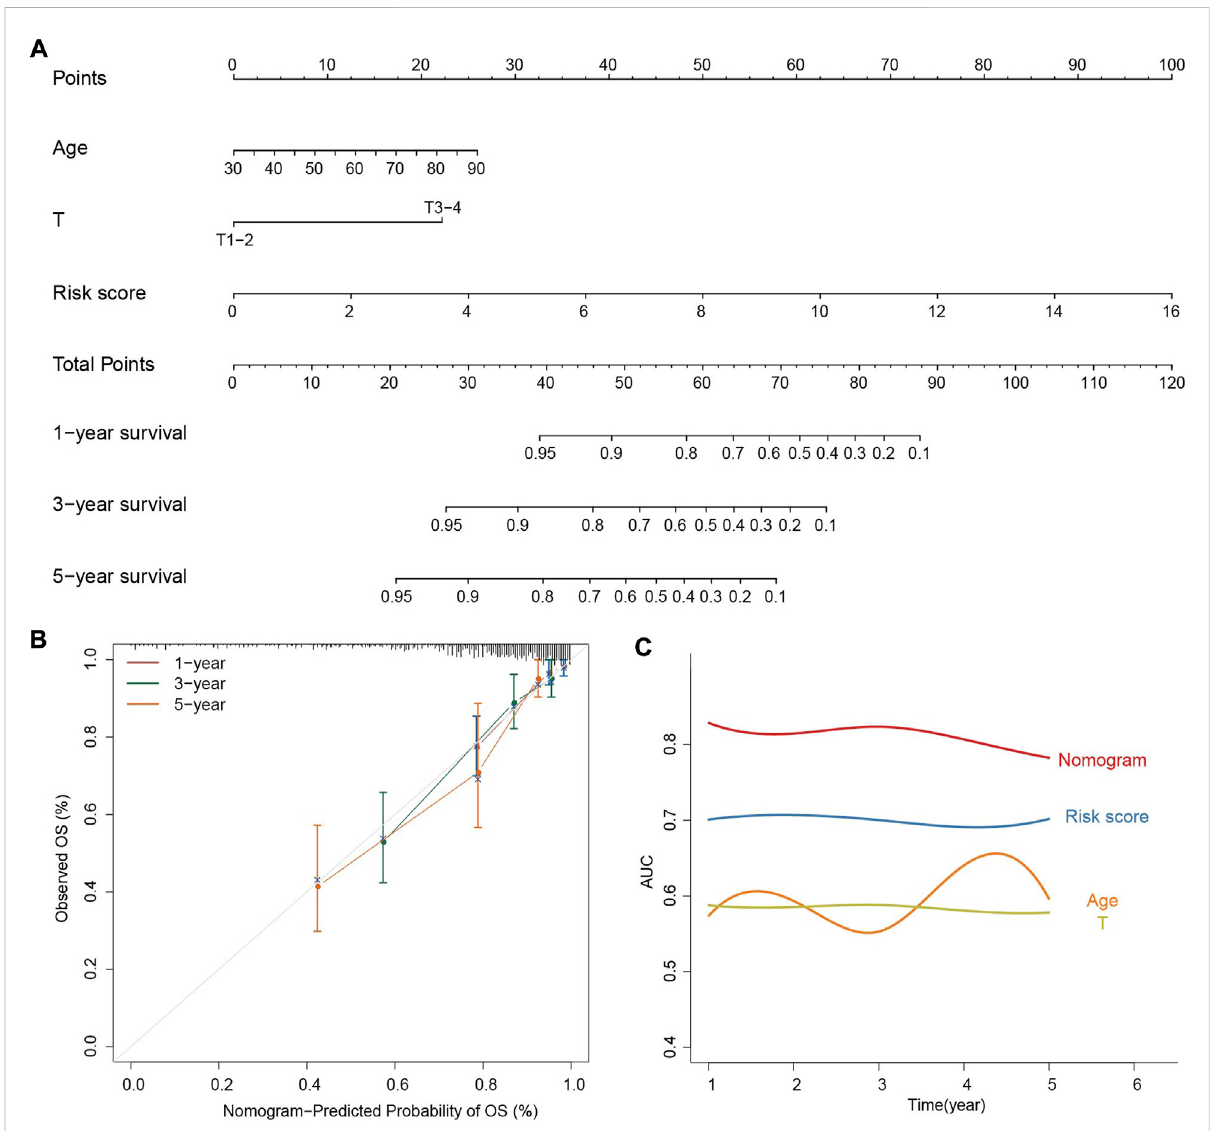
FIGURE 6 Construction and evaluation of the prognostic nomogram. (A) The nomogram predicts the probability of the 1-, 3-, and 5-year OS. (B) The calibration plot of the nomogram for predicting the probability of the 1-, 3-, and 5-year OS. (C) AUC smooth curve for evaluating the accuracy of nomogram predictions.